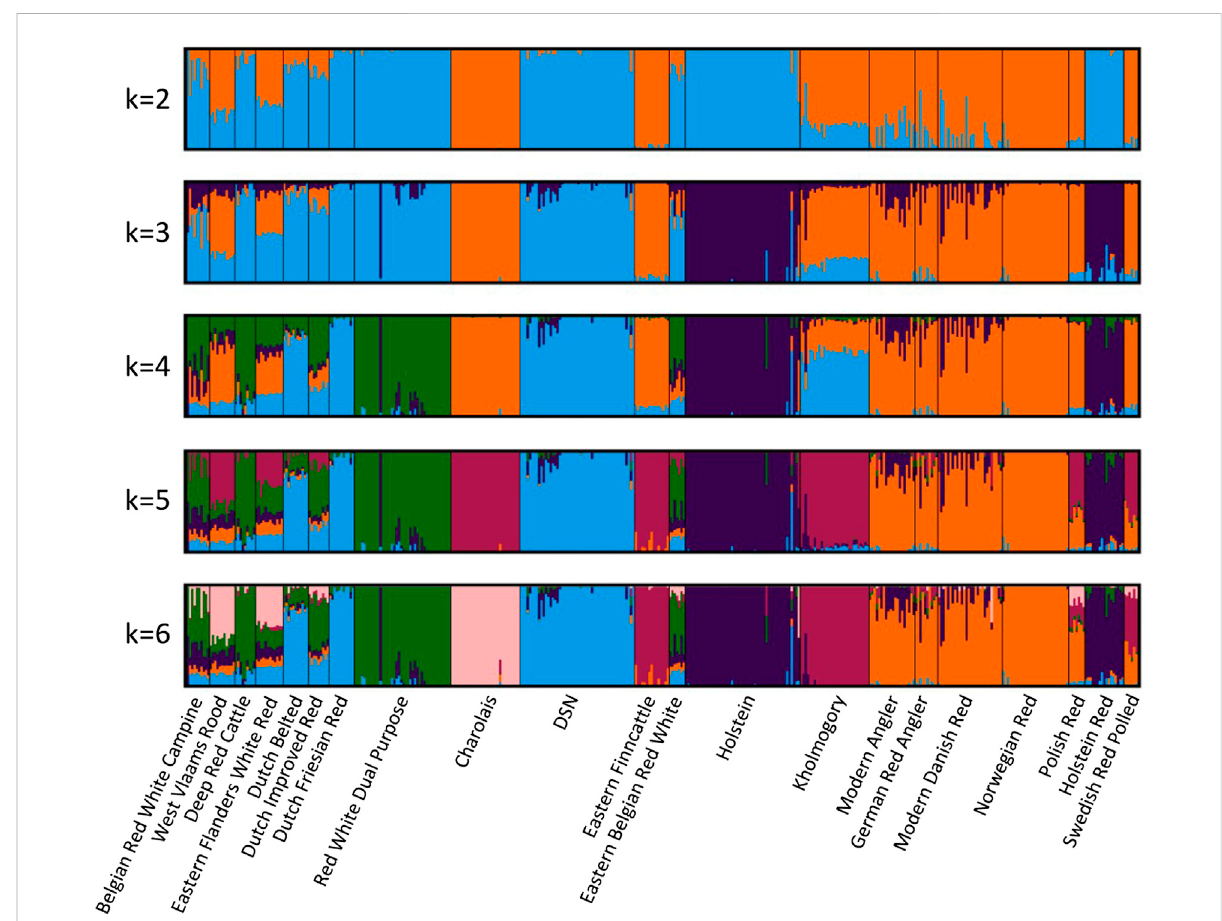
FIGURE 2 AdmixtureanalysisbetweenDSNandthe20breedsclosesttoDSNaccordingtotheF ST values. K =4wasoptimalforthe5-foldcross-validation. Colors indicate the ancestral relationship between